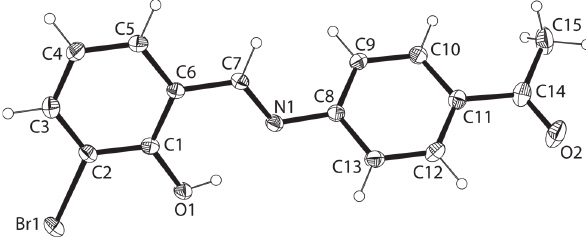
Table 1: Data collection and handling.